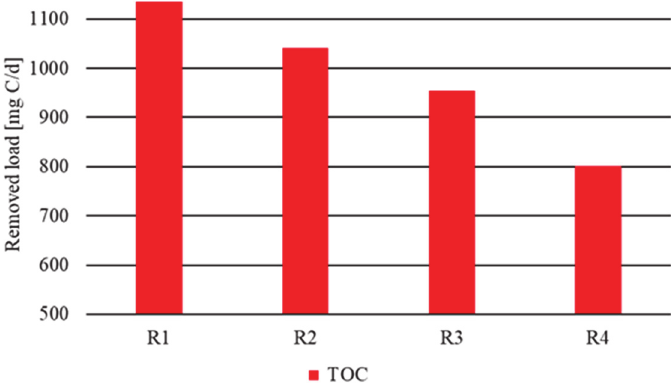
Figure 5. Organic compound load removed in the BER.